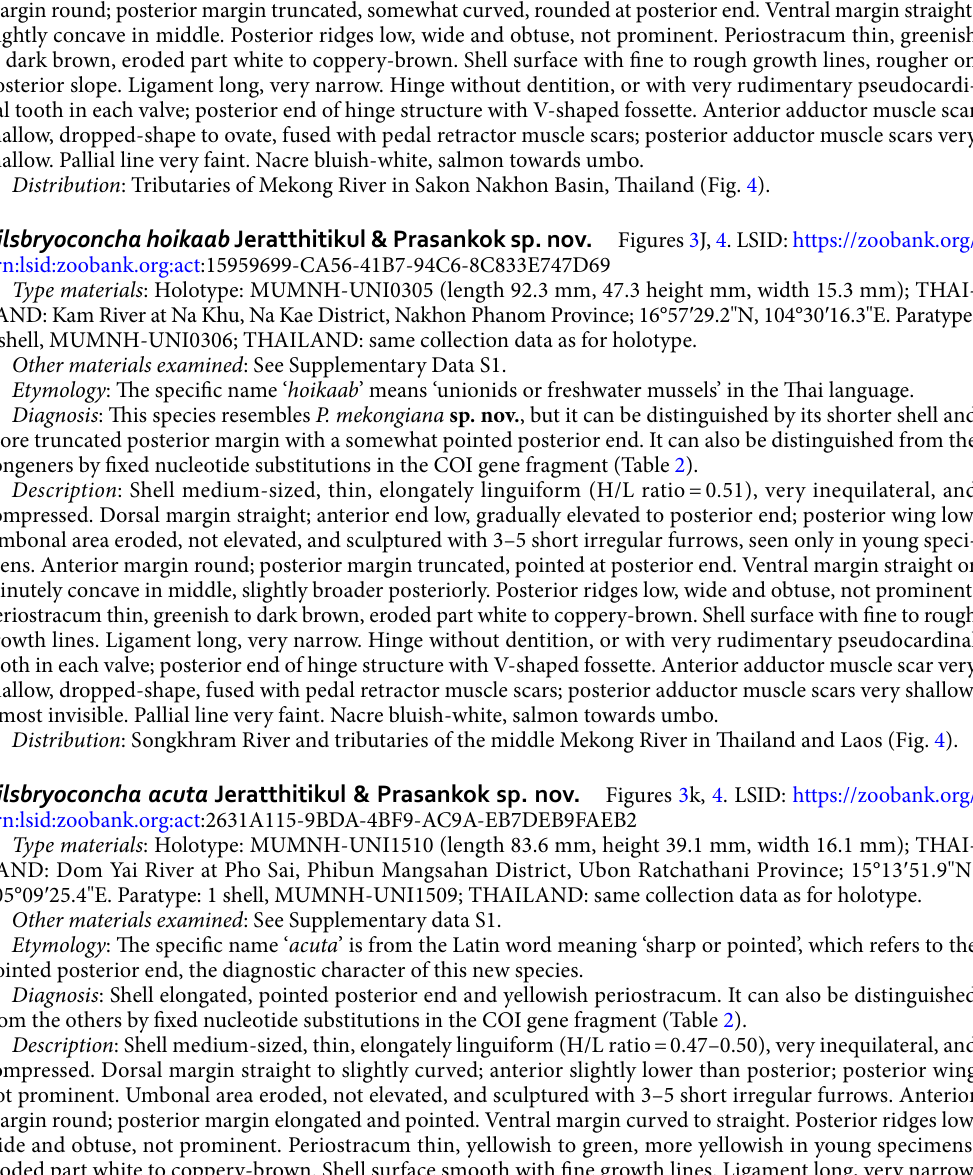
Figures 3J, 4. LSID: https:// zooba nk. org/